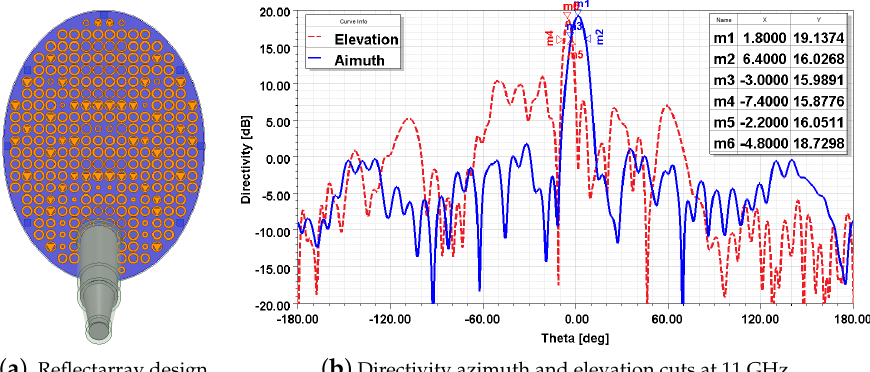
Figure 8. Reflectarray modelled in HFSS and simulation results showing RP cuts.